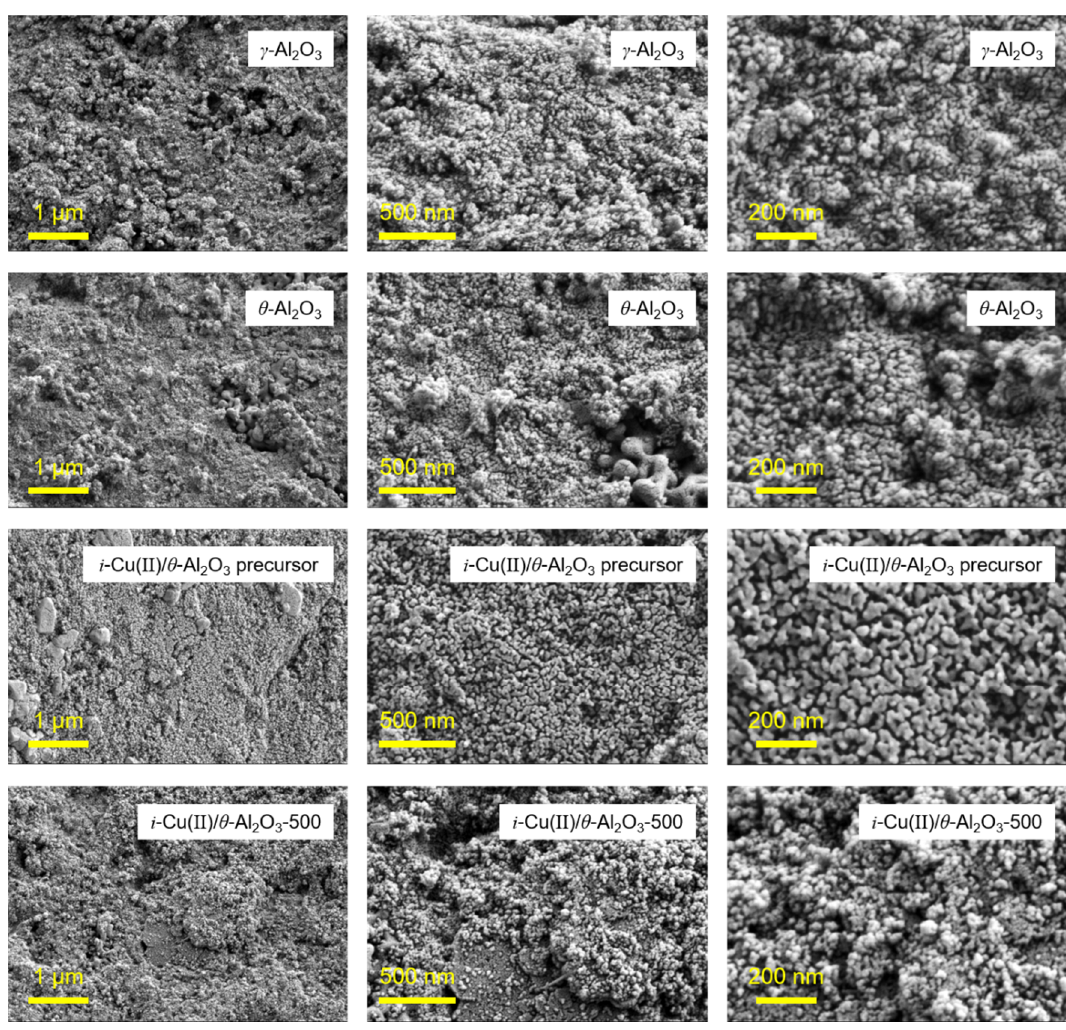
Figure 4. SEM image of γ-Al 2 O 3 , θ-Al 2 O 3 , i-Cu(II)/θ-Al 2 O 3 precursor and i-Cu(I)/θ-Al 2 O 3 -500. (The magnification of images in the first, second and third rows are 20,000, 50,000 and 100,000, respec- tively).